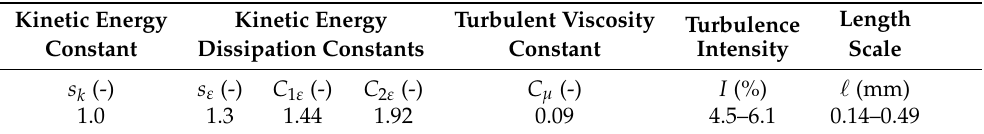
Table 2. Turbulence model parameters.